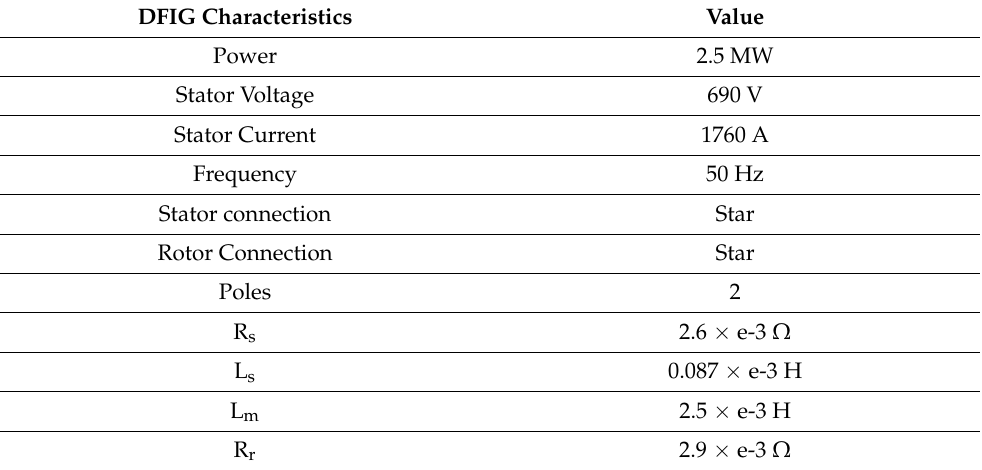
Table 2. DFIG parameters.